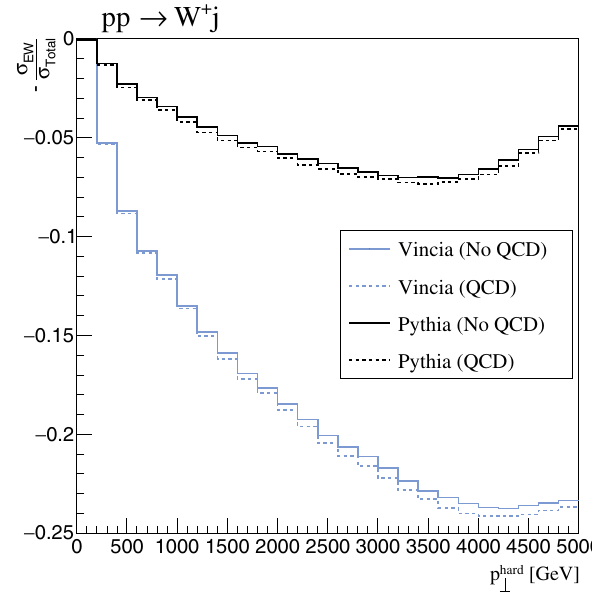
Fig. 6 Electroweak shower approximation of electroweak virtual cor- momentum of the hard scattering process p Hard ⊥ . The solid line corre- rectionstoexclusivedijetproductionandexclusive W + +jetproduction sponds to the parton shower prediction without the QCD shower, while √ s = 14 TeV as a function of the transverse the dashed line shows the effect of interleaving with QCD radiation at center-of-mass energy